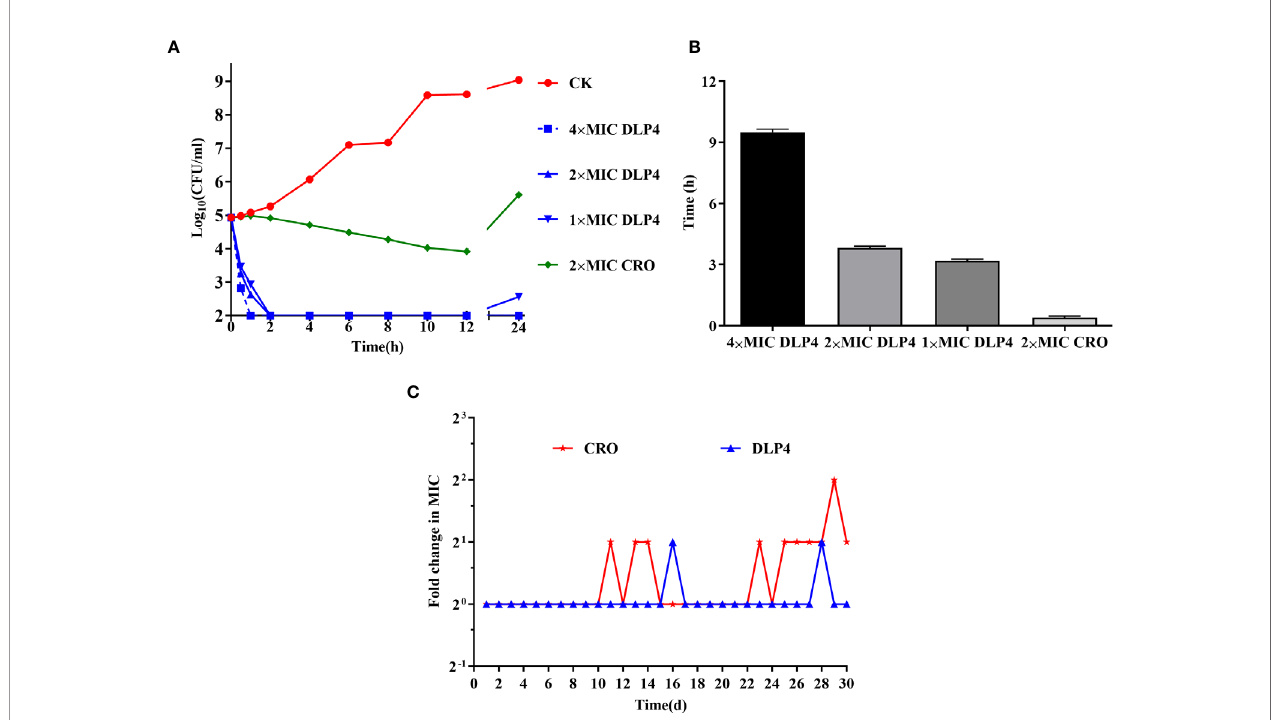
FIGURE 1 | In vitro antibacterial activity. (A) Time-kill curves of peptides and antibiotics against the S. hyicus ACCC 61734 in vitro . CK: S. hyicus ACCC 61734 was cultivated in culture medium without any drugs. Three duplicate observations were made, results were given as mean ± SD (n = 3). (B) The PAE (h) of different doses of drugs. Results were given as mean ± SD (n = 3). (C) Drug resistance evolution of S. hyicus cultured with sub-MIC DLP4 and ceftriaxone.